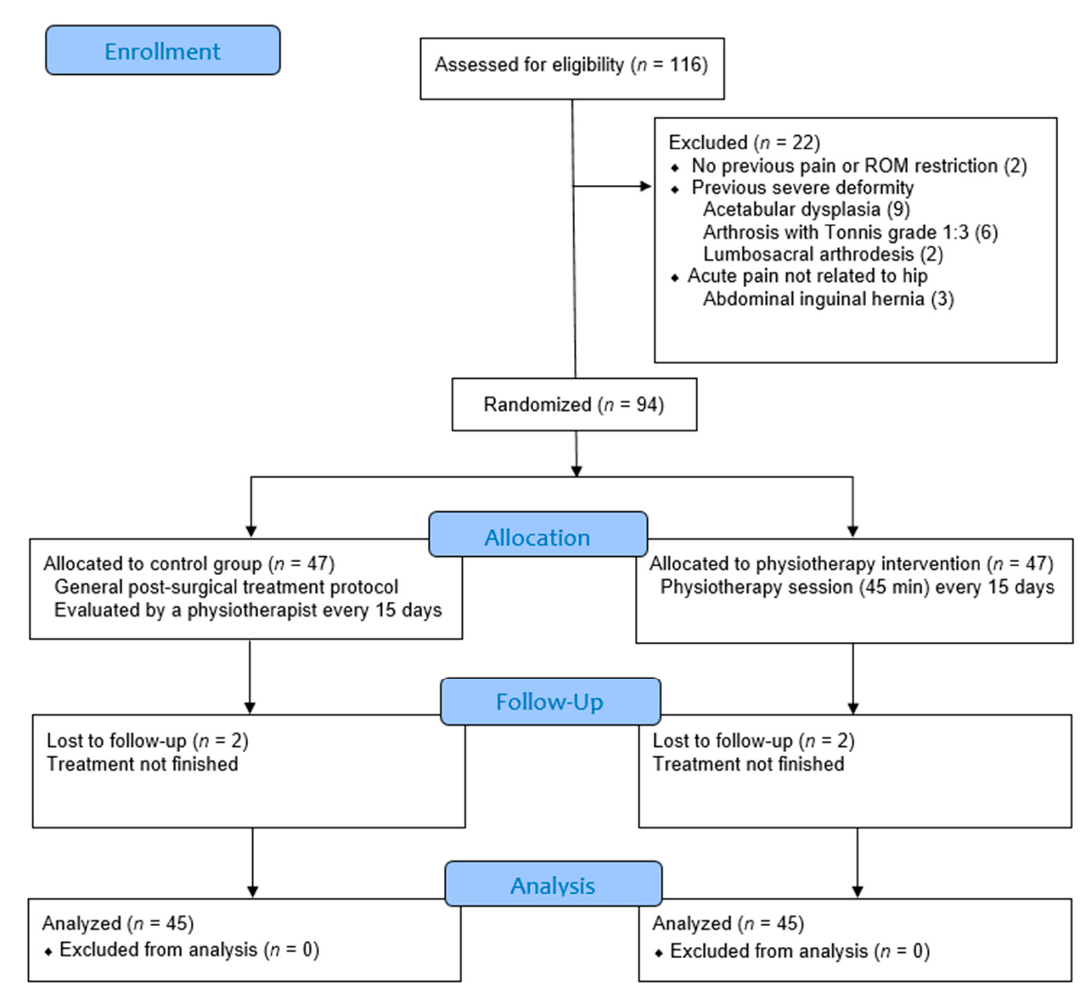
Figure 1. Flow diagram of the study protocol. Abbreviations: ROM (goniometry range of motion).